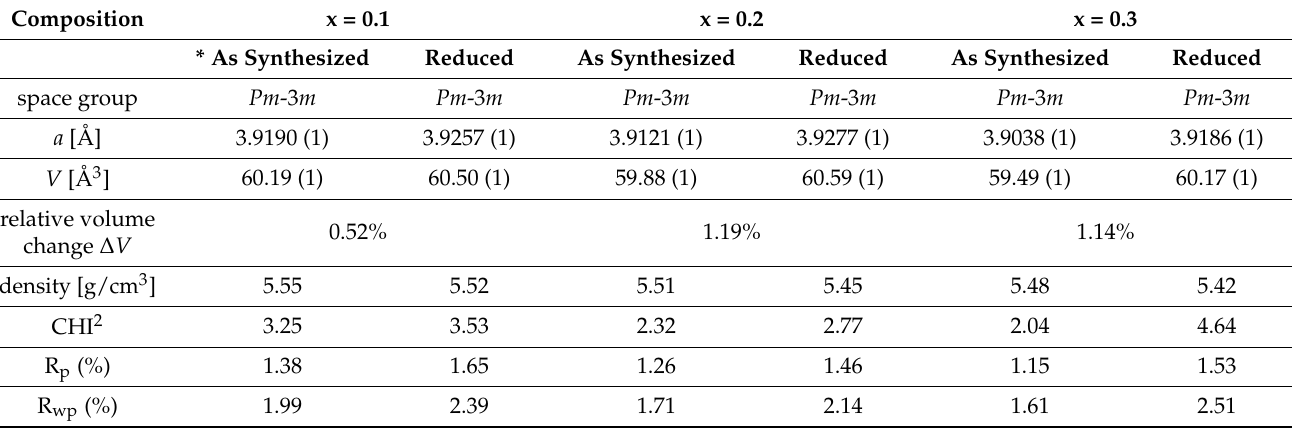
Table 1. Rietveld refinement results including unit cell parameters for the as-synthesized and